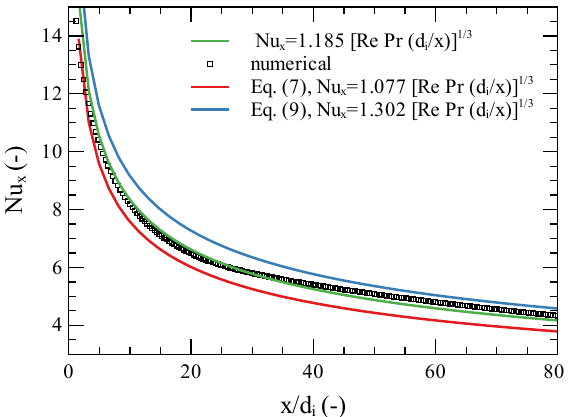
Figure 7. Numerical solution for the time-dependent boundary condition compared to the solution for the first and second boundary conditions. Deviations from pure power behavior are visible. The green line represents the regression for the numerical values if the same function was used as in the other